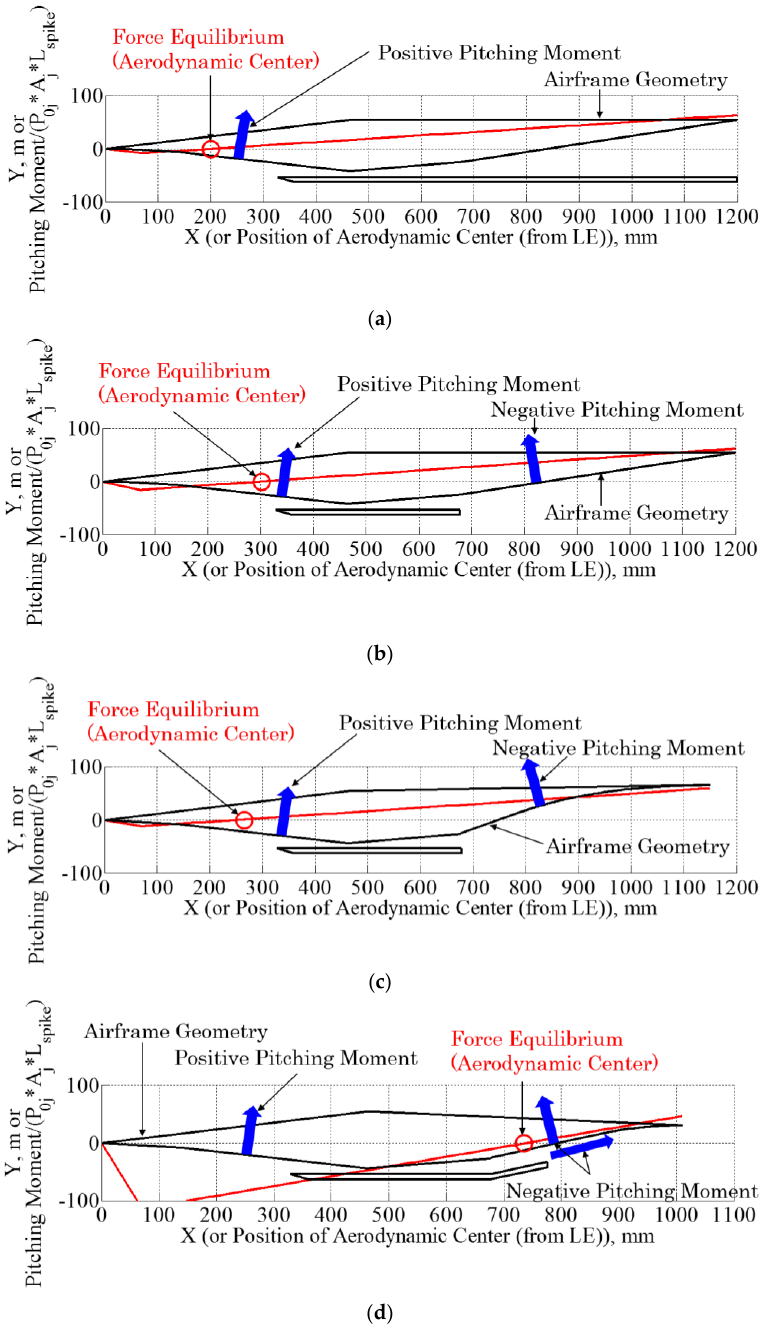
Figure 14. Pitching moment distributions (red line) superimposed on the center cut of the airframe geometry (black line) for the baseline and proposed cases. The red circle indicates the aerodynamic center location. The flow direction is from left to right. ( a ) Case 1 ; ( b ) Case 2 ; ( c ) Case 3 ; ( d ) Case 4 .